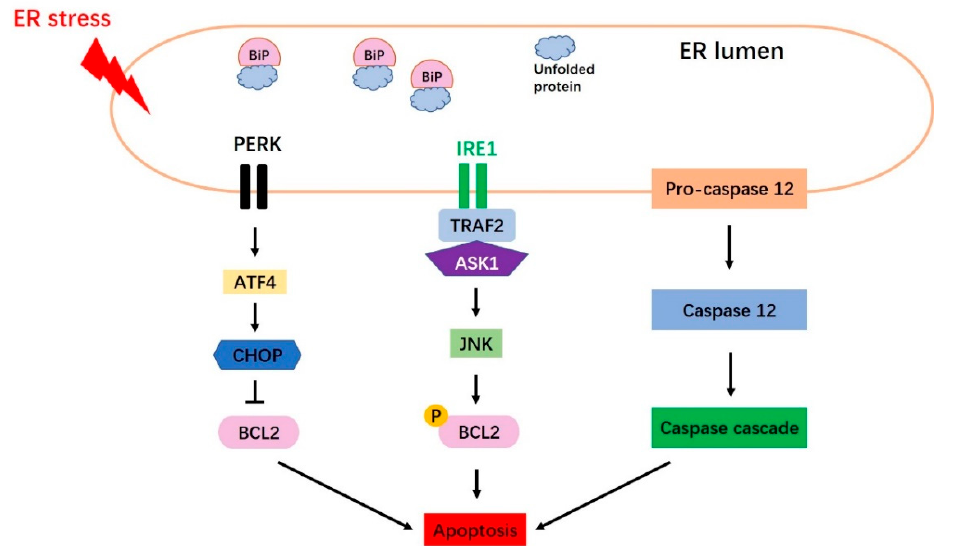
Figure 3. Schematic diagram of apoptosis induced by Endoplasmic Reticulum (ER) stress. Three main pathways of ER stress-mediated pro-apoptotic signaling are shown, namely the CHOP pathway, the JNK pathway and the caspase 12